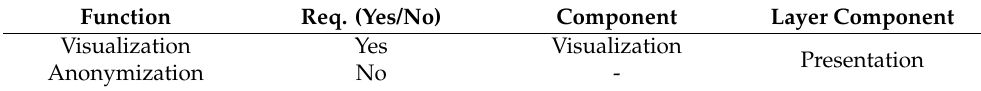
Table 6. Application of CTI Reference Model: Presentation Layer. Function Req. (Yes/No) Component Layer Component Visualization